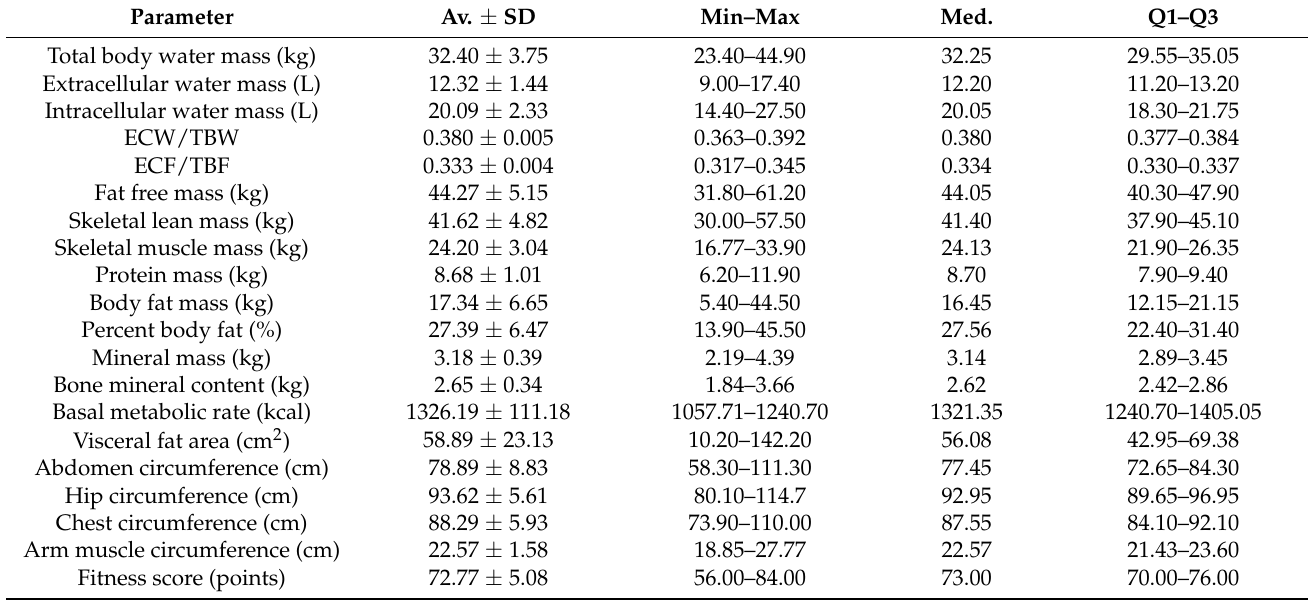
Table 3. Descriptive characteristics of the body composition parameters estimated by electrical bioimpedance